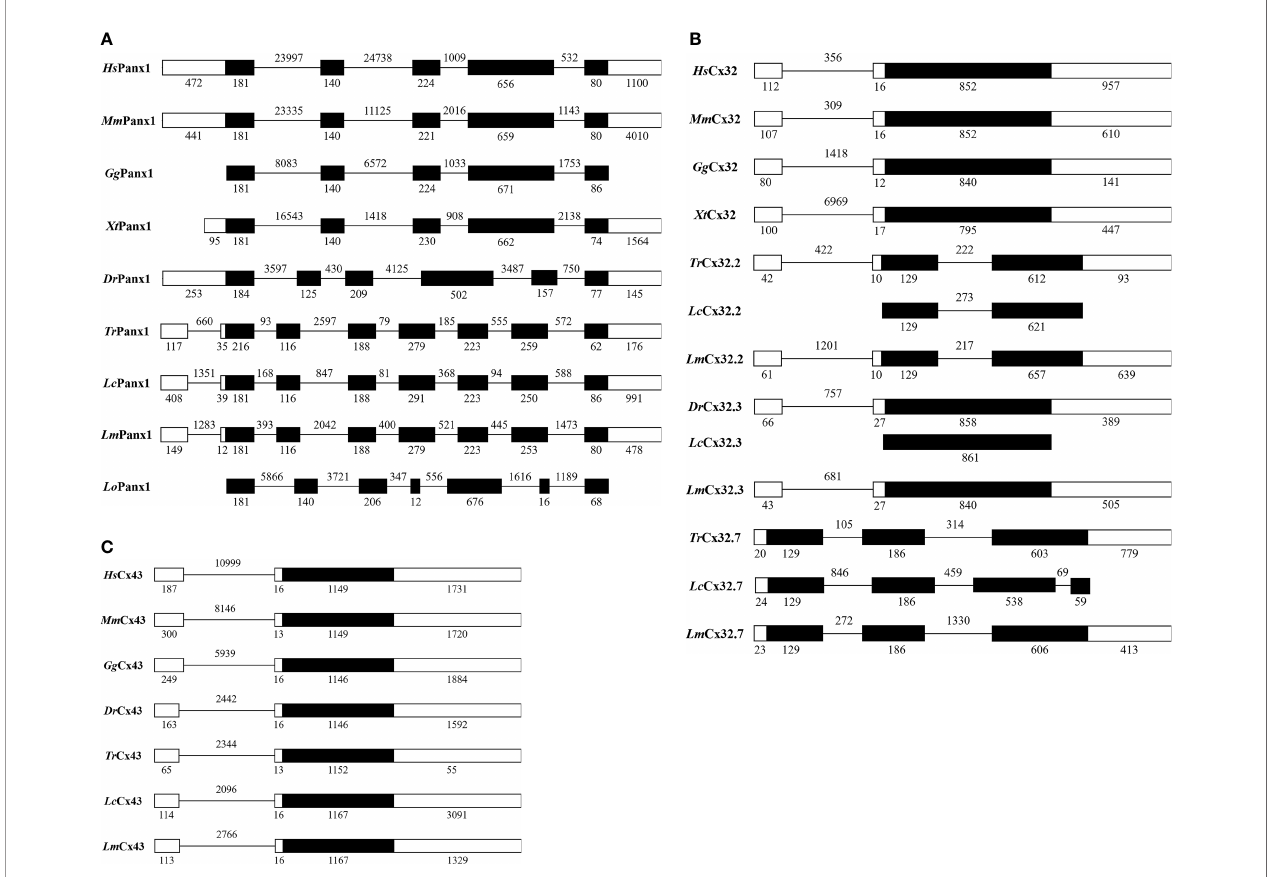
FIGURE 3 | Genomic organization of Panx1 (A) , Cx32 (B) , and Cx43 (C) . Blank and solid boxes indicate UTR and coding exon, respectively. The size (bp) of exons and introns is indicated. Note that the size of exons and introns is